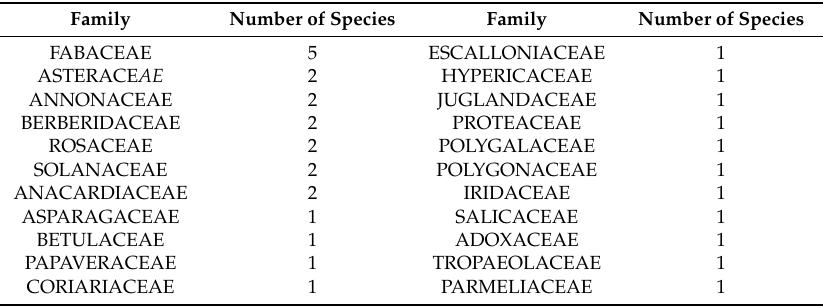
Table 3. Number of dye plant species by family.